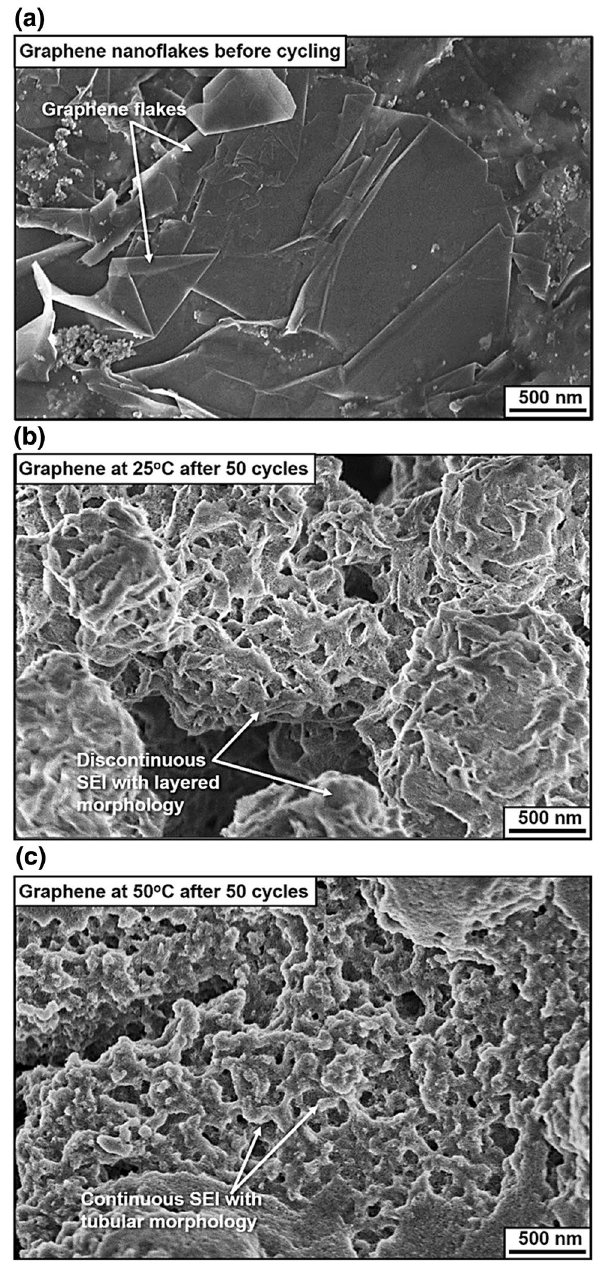
Fig. 5 SE-SEM images obtained from graphene nanoflake-based anodes a before cycling and after 50 cycles at b 25 °C and c 50